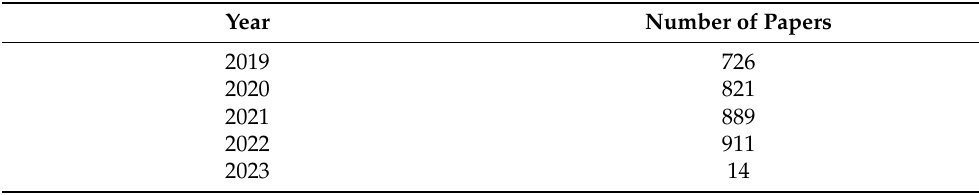
Table 5. Number of indexed articles per year, over the 2019–2023 period, considered for this re- view. Reported results derived from the analysis of articles identified during the first round of bibliographical research.